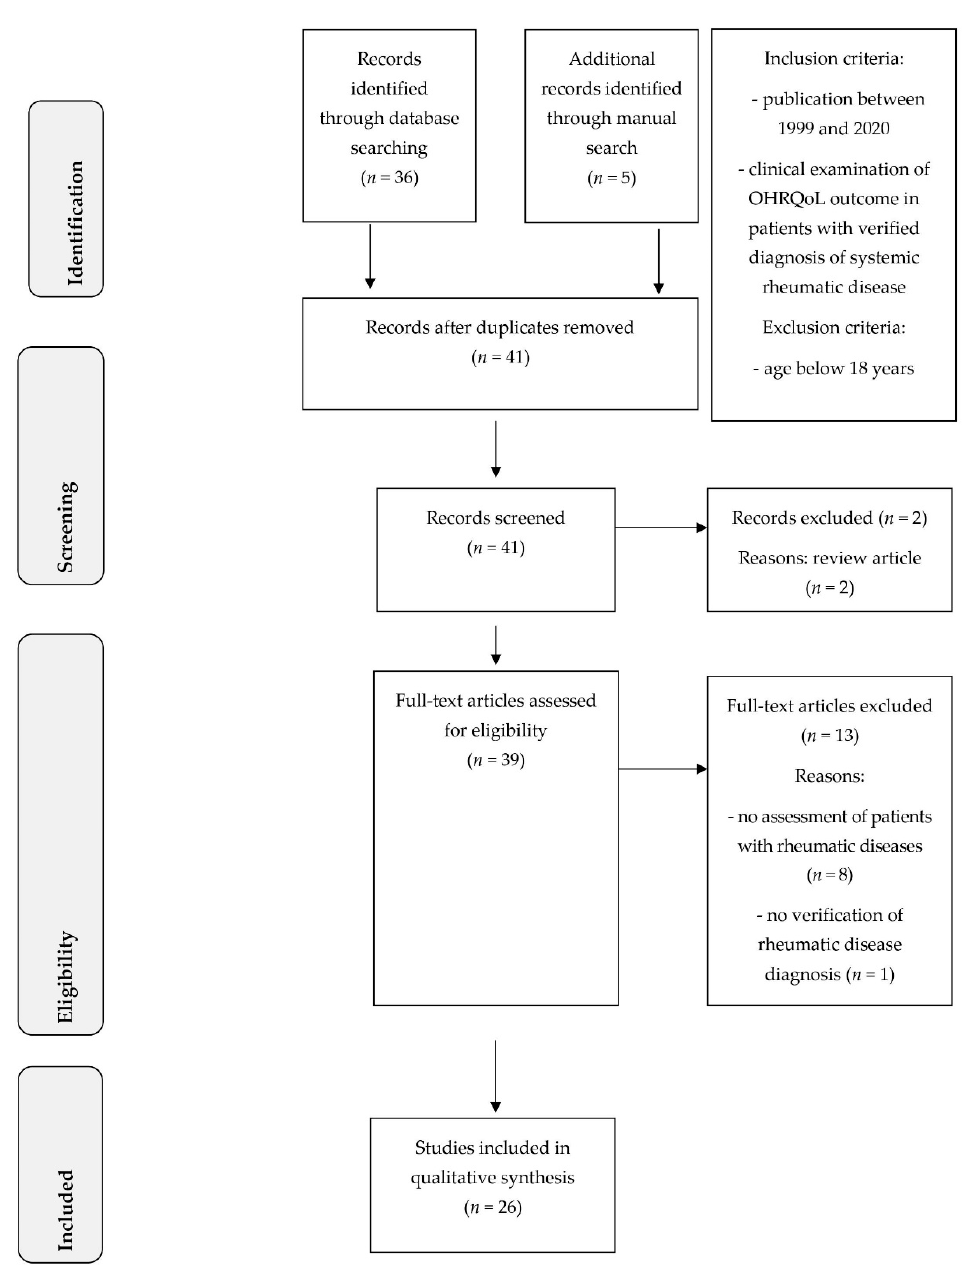
Figure 1. PRISMA (Preferred Reporting Items for Systematic Reviews and Meta-Analyses) diagram for systematic review